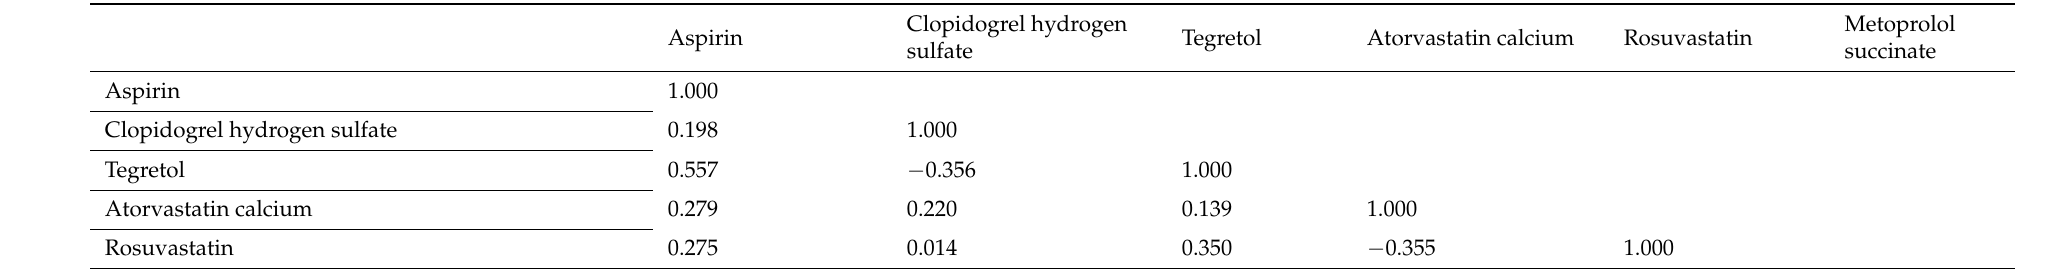
Table 7. The comparison of the correlation analysis results for medicines used for Scenario One’s study using quantity